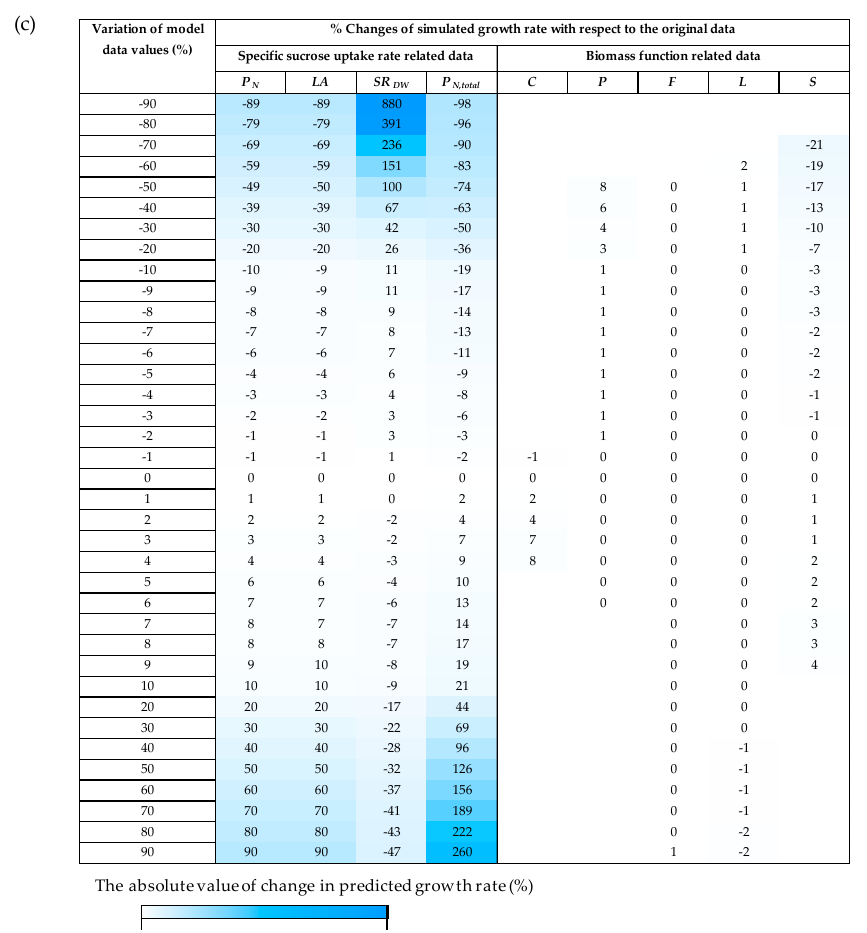
Figure A1. Sensitivity analysis of ( a ) variations in sucrose uptake rate-related data and ( b ) variations of biomass function-related data to the predicted storage root growth rate of the rMeCBM-KU50 model. ( c ) The percentage changes of predicted growth rate with respect to the original data. Each radar graph, the radial axes is the error percentage of model simulation to measured storage root growth rate. LA ; total leaf area per plant; P N , photosynthetic rate; P N, total , total photosynthetic rate per plant; SR DW , storage root dry weight per plant; C , carbohydrate content; F , fiber content; L , lipid content; P , protein content; S , starch